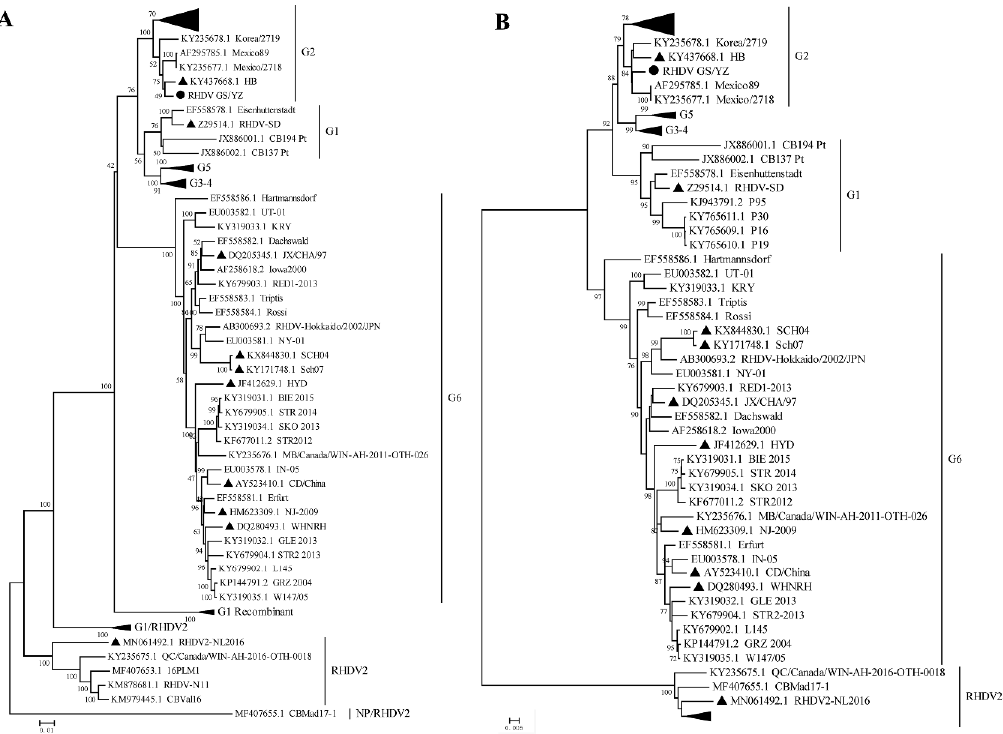
Figure 5. Evolutionary relationships of the new RHDV isolate and reference strains based on the nucleotide sequences of the full-length genome ( A ) and VP60 ( B ). The evolutionary history was inferred using the Neighbor-Joining method implemented in MEGA7 and tested using 1000 bootstrap replicates. Only bootstrap values equal to or greater than 70 are shown. Each sequence is labeled with its GenBank accession number and name beside the branch, with an additional black dot for the new and black triangles for the Chinese strains.